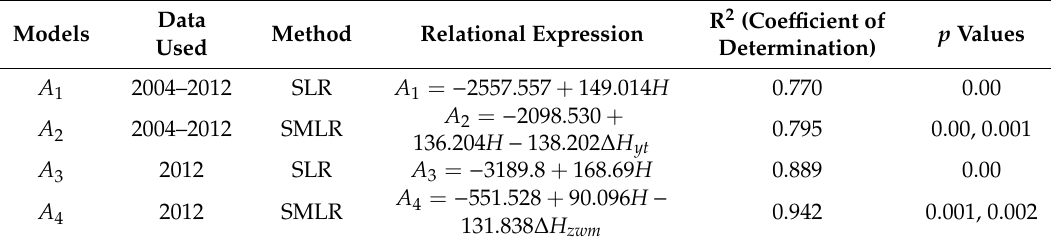
Figure 6. Relation between water area and water level of hydrological stations in 2004–2015. Figure 6 . Relation between water area and water level of hydrological stations in 20 04 –20 15. Table 3. Linear regression Table 3. Linear regression models.